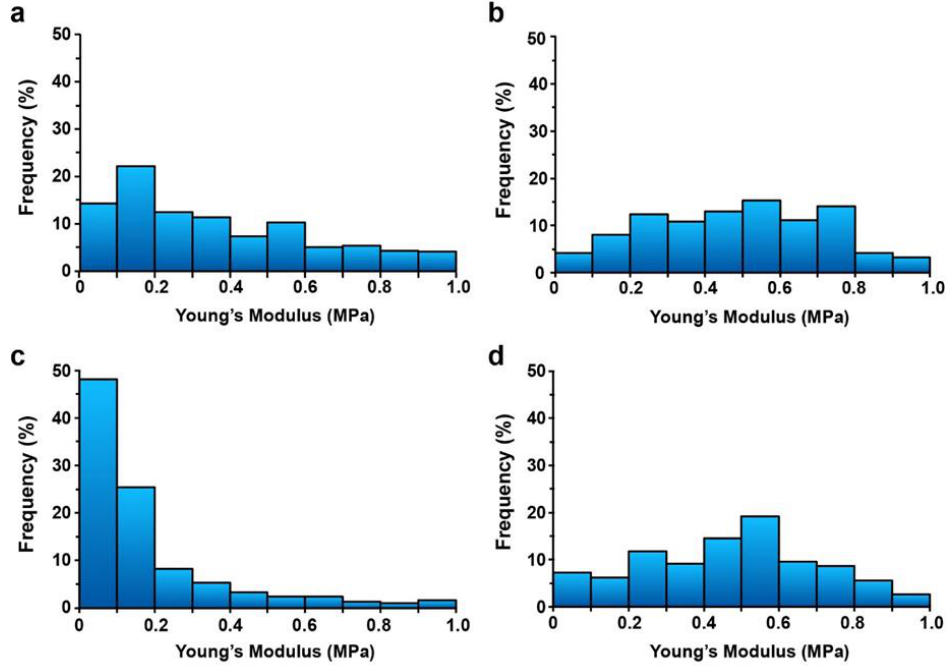
Figure 4. Measurements of cell wall rigidity by Atomic Force Microscopy (AFM). Force curves were recorded at the surface of three to five cells per condition in order to extract Young’s modulus value. Each graph represents the distribution of the relative frequency (%) of Young’s modulus values measured on the cell surface in each condition. Arabidopsis cell suspension were treated for 24 h with: ( a ) control (0.1% methanol), ( b ) 1 mM H 2 O 2 , ( c ) 1 µ M thaxtomin A (TA), and ( d ) pretreated for 3 h with 1 mM H 2 O 2 prior to TA treatment.